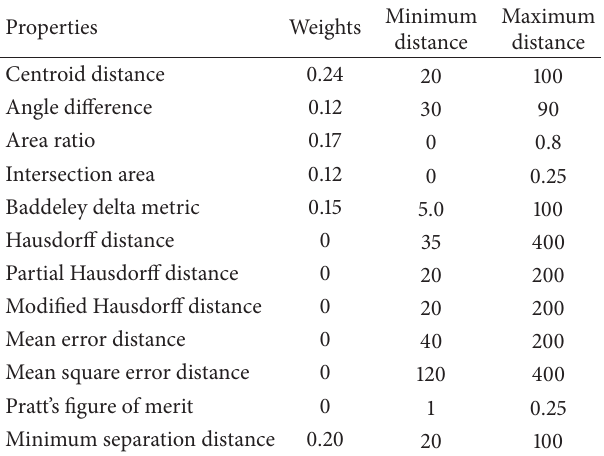
Table 2: Total interest calculation weights and threshold